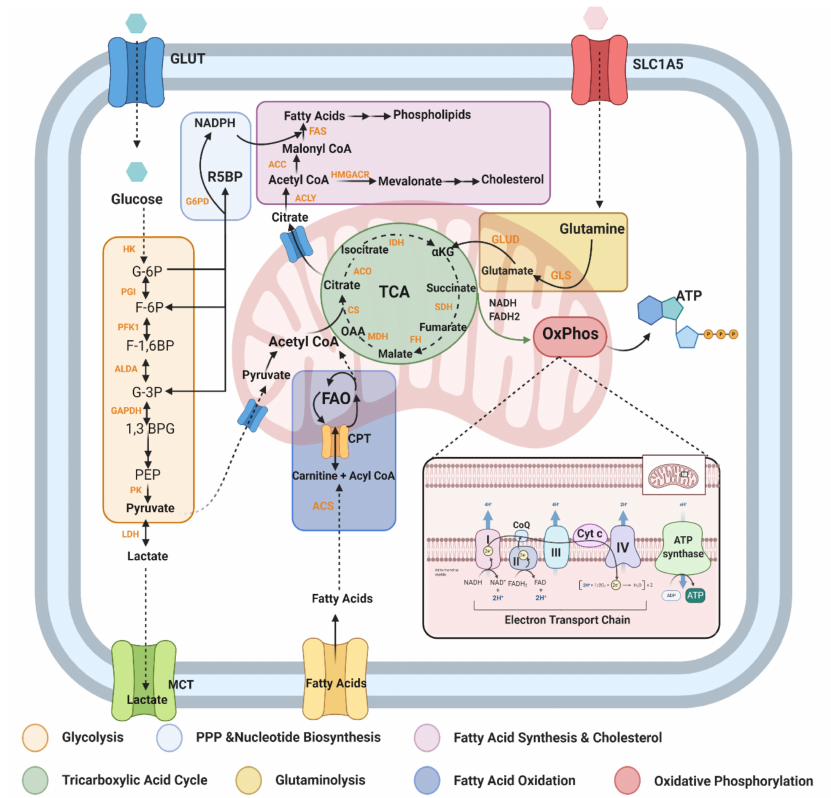
Figure 2. An outline of key metabolic pathways altered upon immune cell activation: Cells modify specific metabolic pathways depending on their requirements for activation, growth, development or survival. This capability to shift utilisation of various pathways to generate energy from nutrients like carbohydrates (e.g., glucose), proteins and fats is termed immunometabolism. ATP: Adenosine Triphosphate; LDH: Lactate Dehydrogenase; MCT: Monocarboxylate Transporter; HK: Hexokinase; G-6P: Glucose-6-Phosphate; PGI: Phosphoglucoisomerase; F-6P: Fructose-6-phosphate;